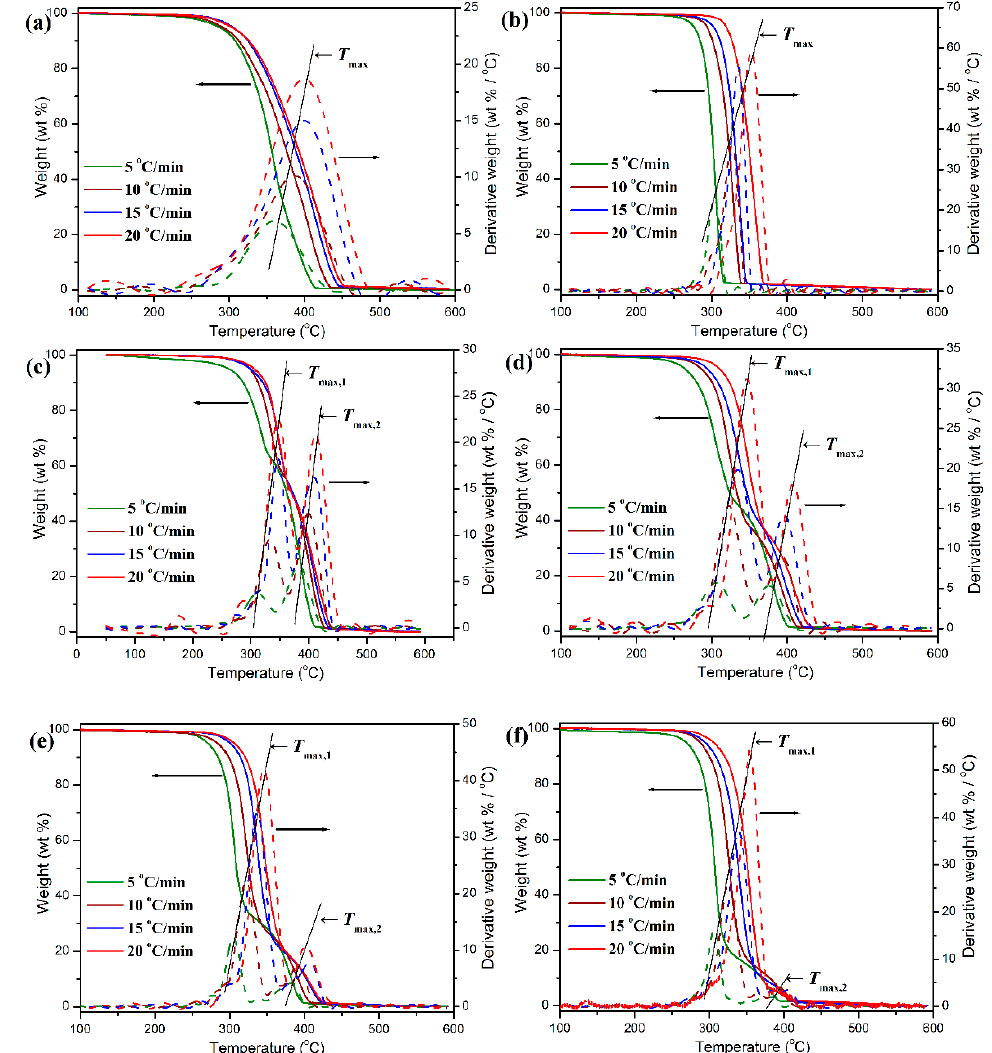
Figure 13. TGA and derivative thermogravimetric (DTG) thermograms of ( a ) pure POM, ( b ) pure PLA, and its blends with ( c ) 10 wt %, ( d ) 20 wt %, ( e ) 30 wt %, ( f ) 50 wt % of PLA during the isothermal crystallization process.